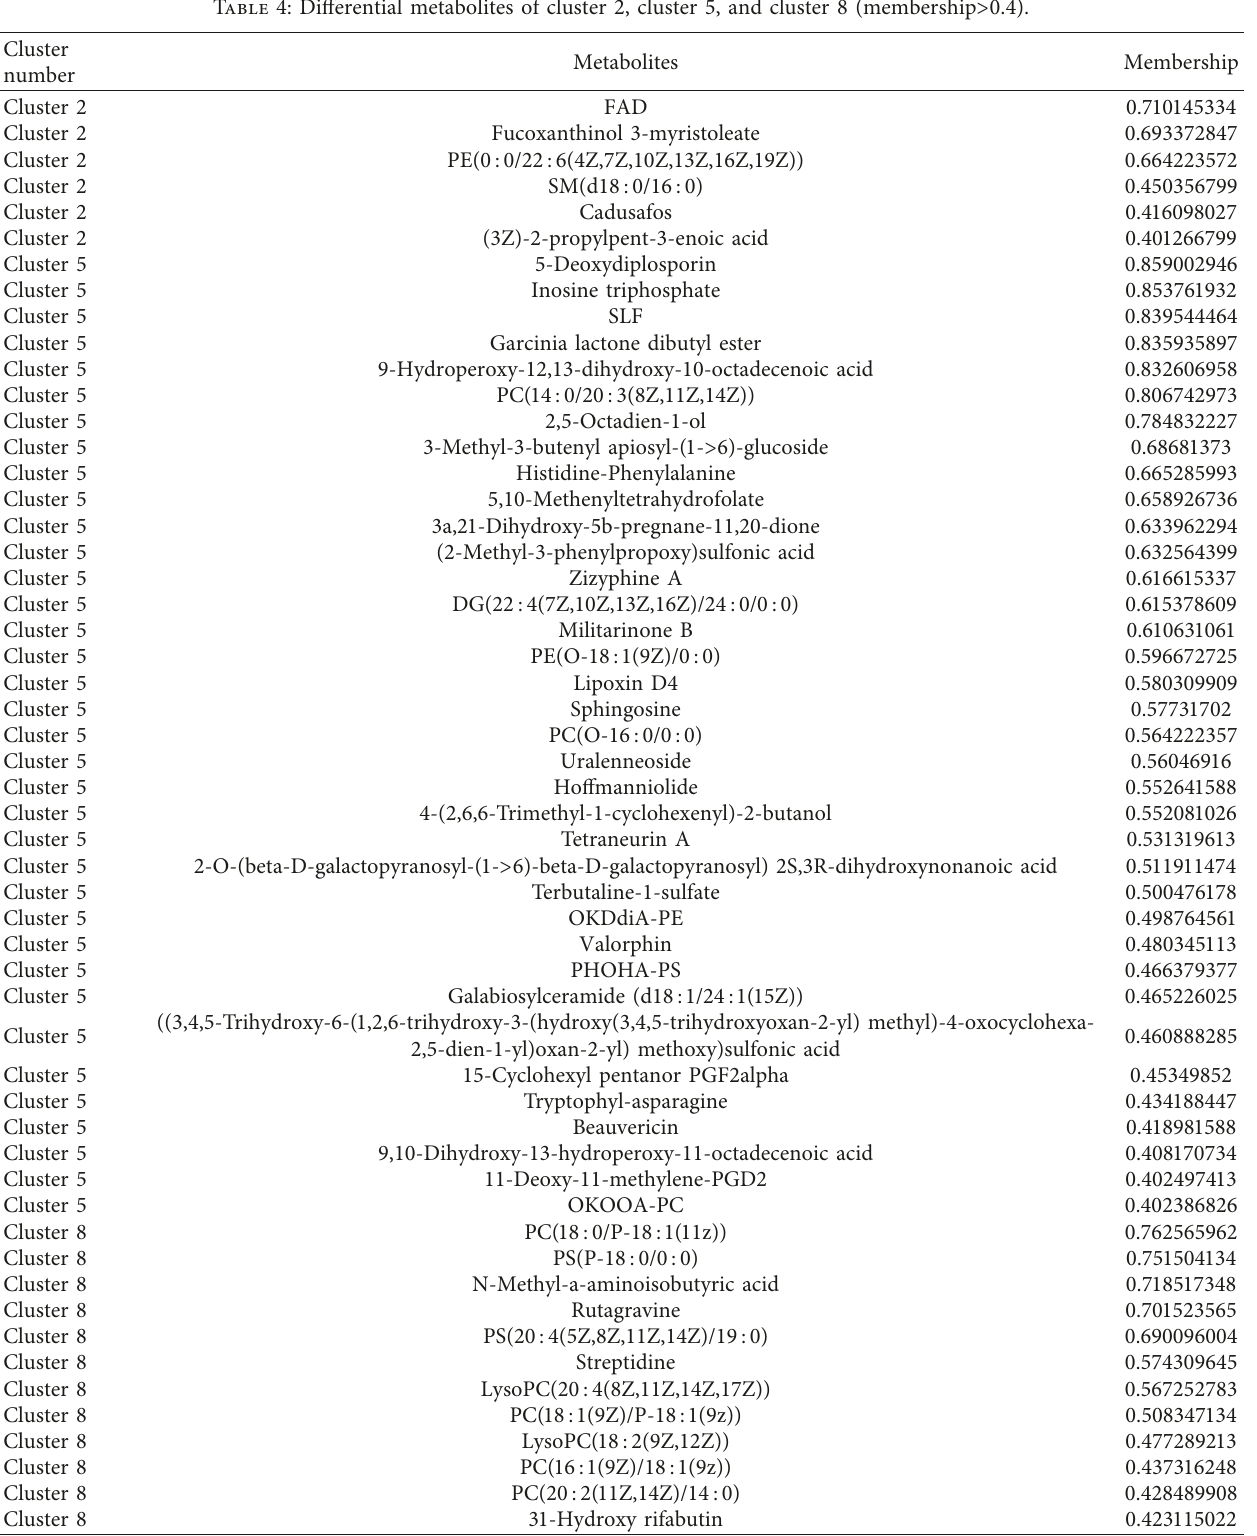
Table 4: Differential metabolites of cluster 2, cluster 5, and cluster 8 (membership >